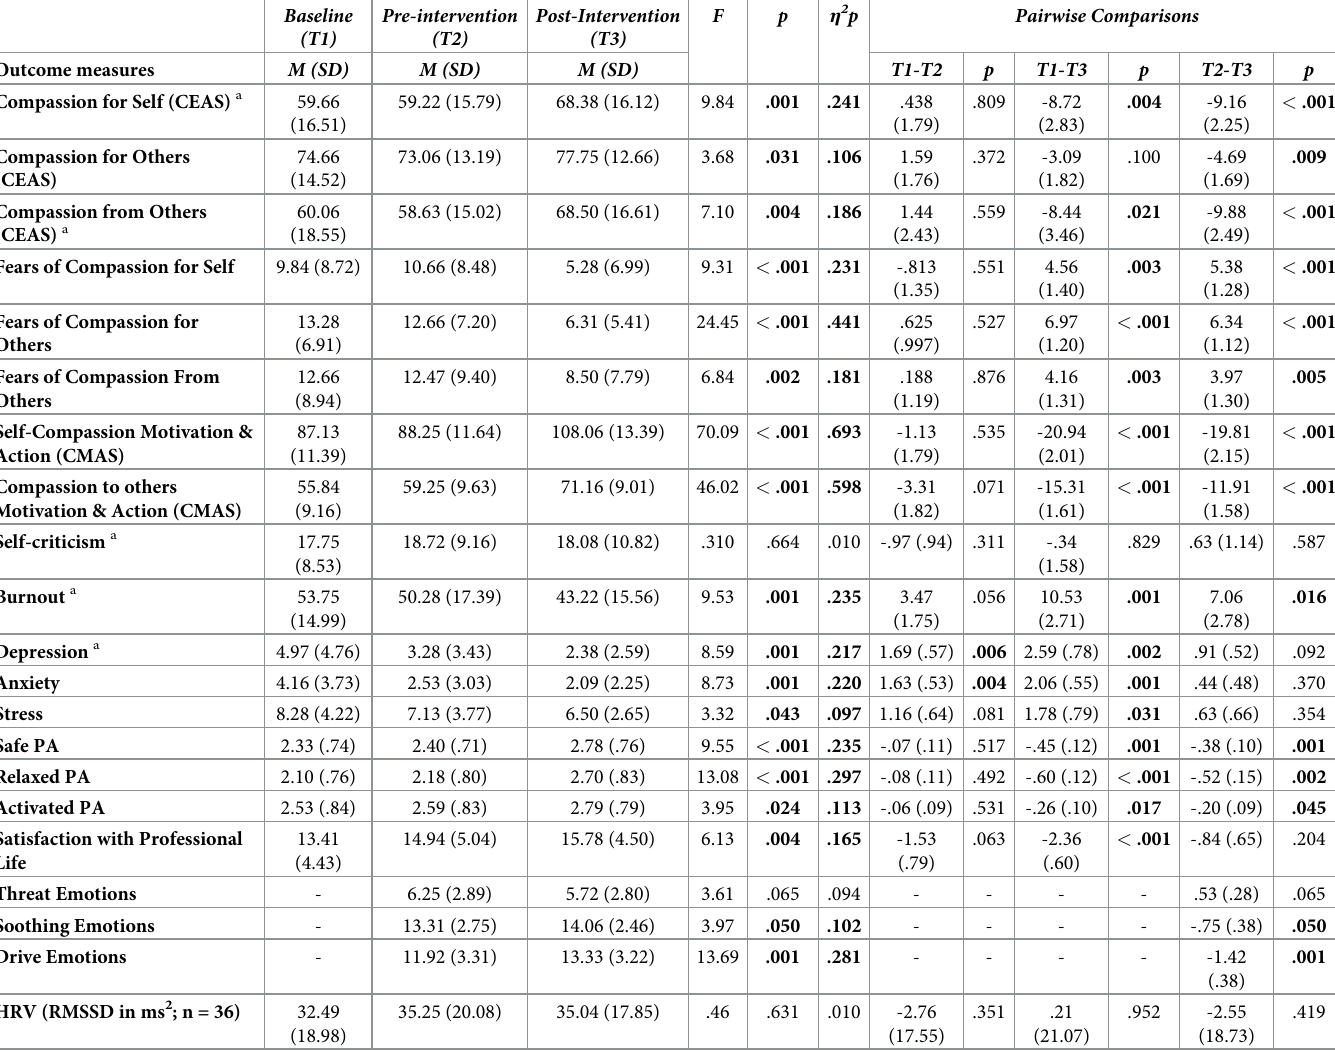
Table 6. Means and SDs of the outcome measures at baseline (T1), pre-intervention (T2) and post-intervention (T3) and repeated measures analysis of variance ( N = 37) and pairwise comparisons, for the WLC group participants who completed the CMT-T intervention between T2 and